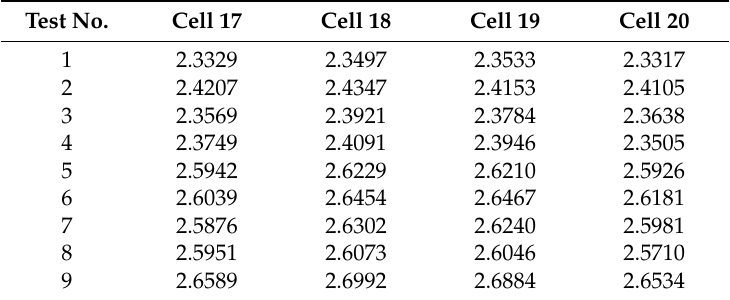
Table 13. The discharge capacity of nine sets of